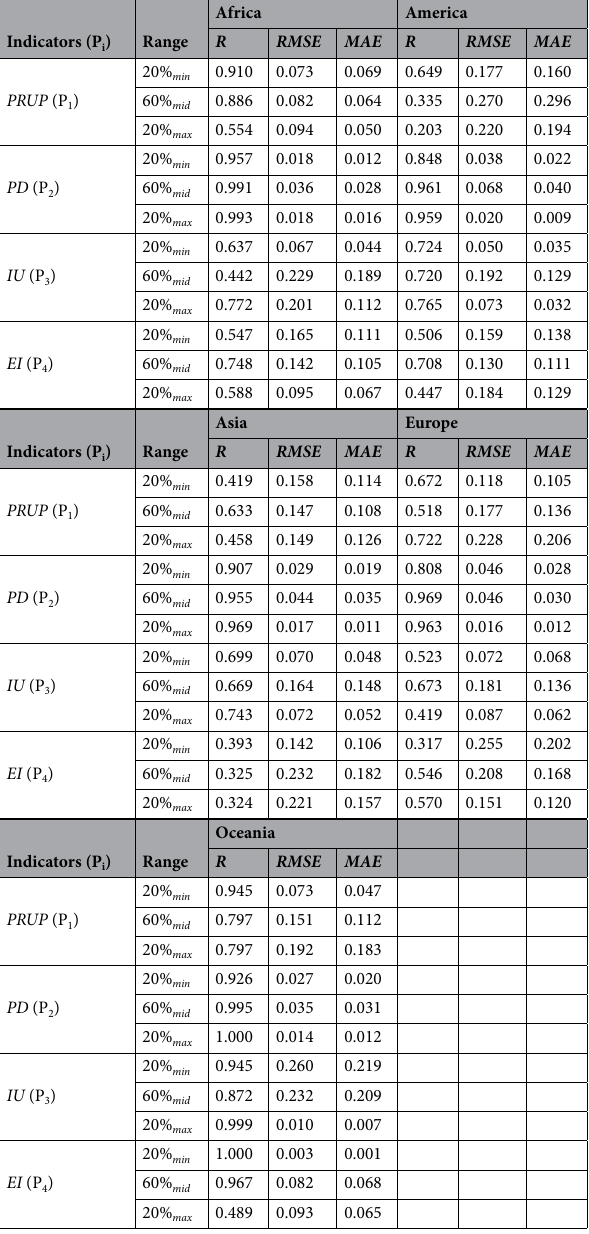
Table 7. The performance of GEP models with respect to selected